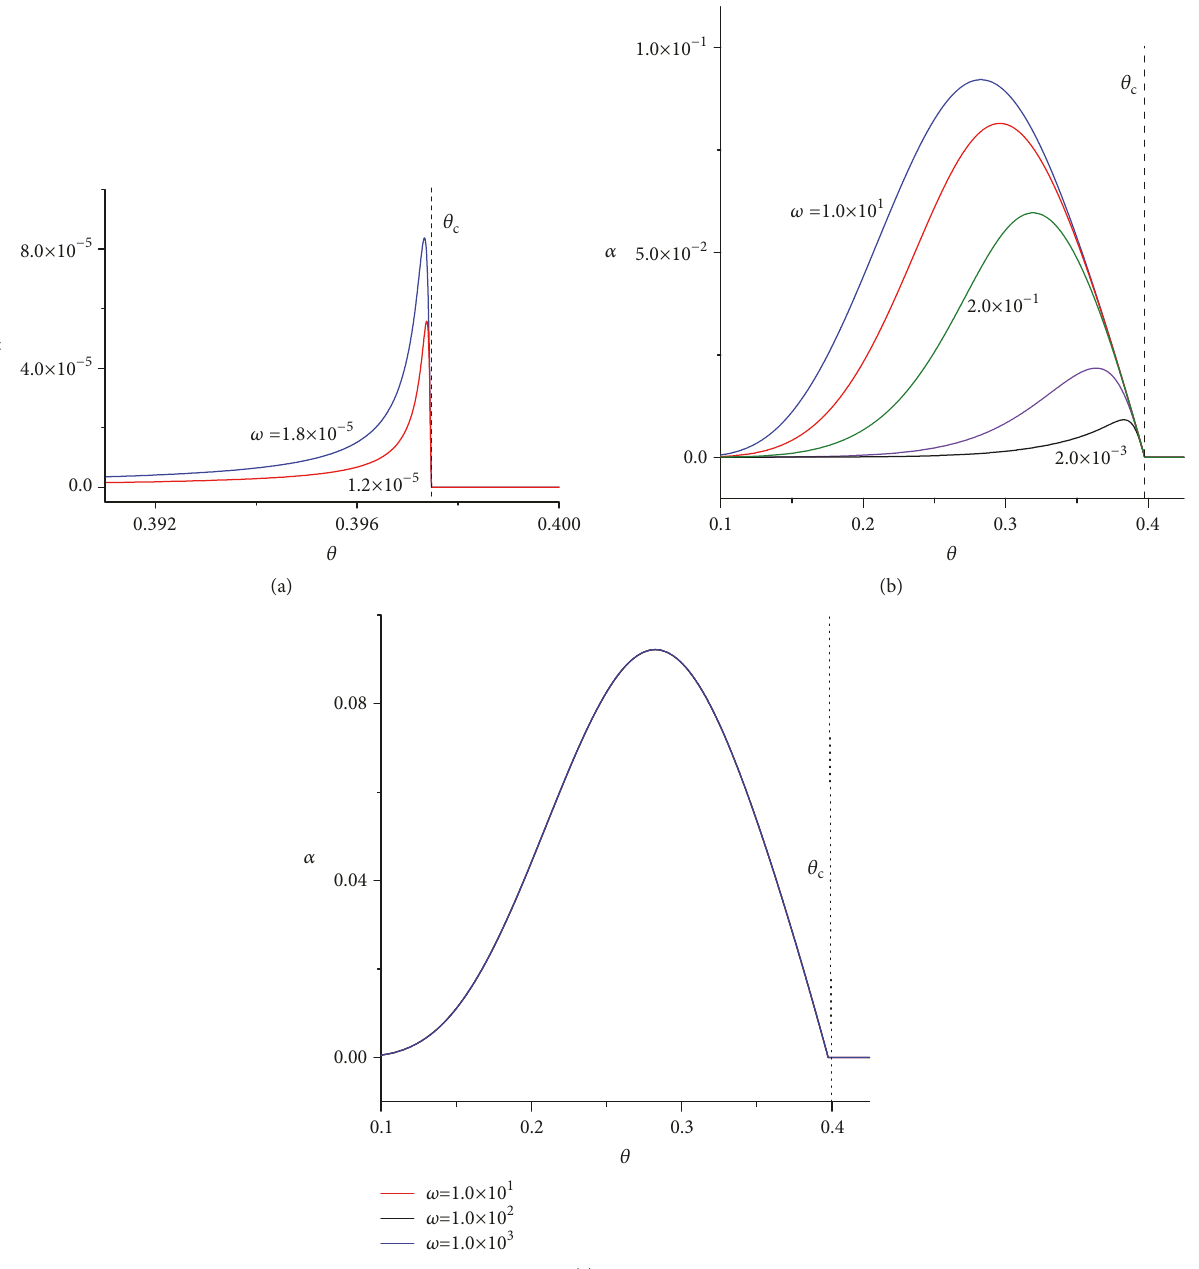
Figure 3: Sound attenuation 𝛼 as a function of the reduced temperatureat several sound frequency values 𝜔 in the neighborhood of a critical point for 𝑝 = 0.98 , 𝑑 = 𝑑 𝐶 = 0.45 , and 𝐿 = 0.02 . The number accompanying each curve denotes the value of the frequency 𝜔 and the vertical dotted line represents the critical temperature in the ordered